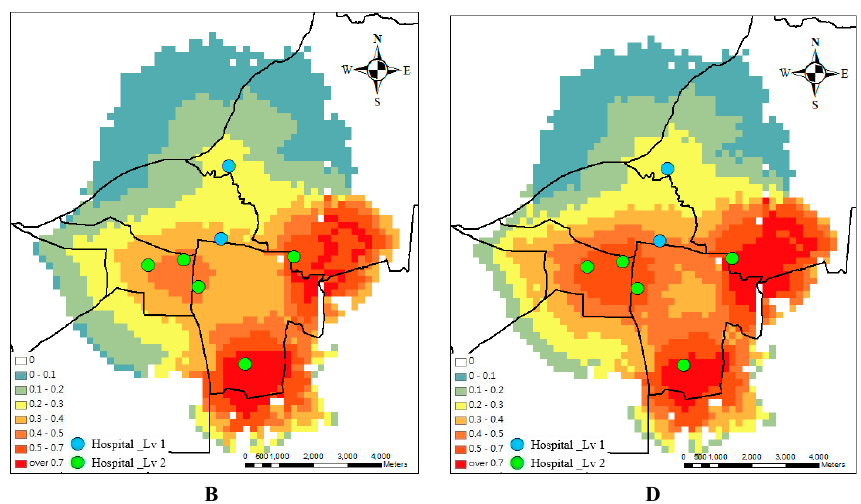
Figure 4. Accessibility before the optimal design at week 1 ( A ); week 2 ( B ); week 3 ( C ) and week 4 ( D ).